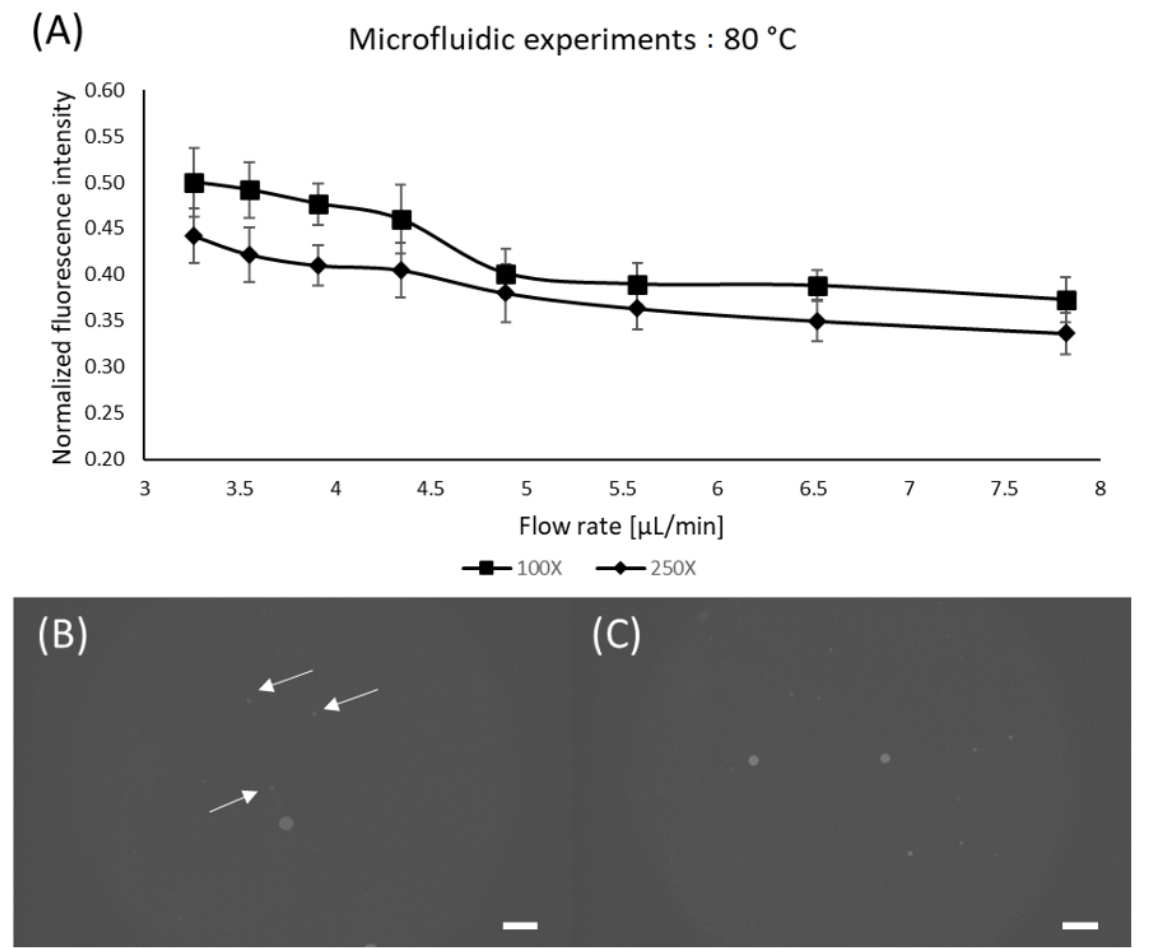
Figure 6. Microfluidic staining. ( A ) Effect of flow rate for fixed temperature; ( B ) PE microspheres stained using 100X Nile Red at 5.58 µL/min; ( C ) PE microspheres stained using 100X Nile Red at 3.26 µL/min; Scale bars are 100 µm. Arrows were added to indicate the particles of interest.